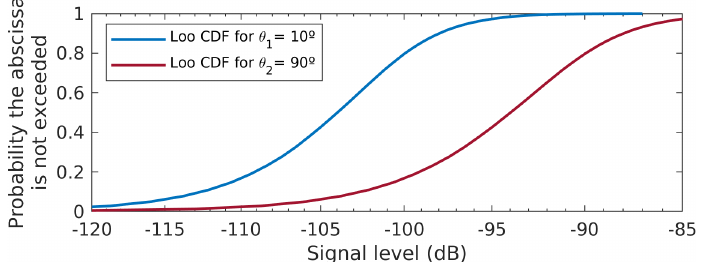
Figure 6. Loo CDF of the received signal for two elevation angle values. The Loo triplet for θ 1 = 10 ◦ is α = − 105 dB, ψ = 5 dB, and MP = − 108 dB; and α = − 95 dB, ψ = 5 dB, and MP = − 98 dB for θ 2 = 90 ◦